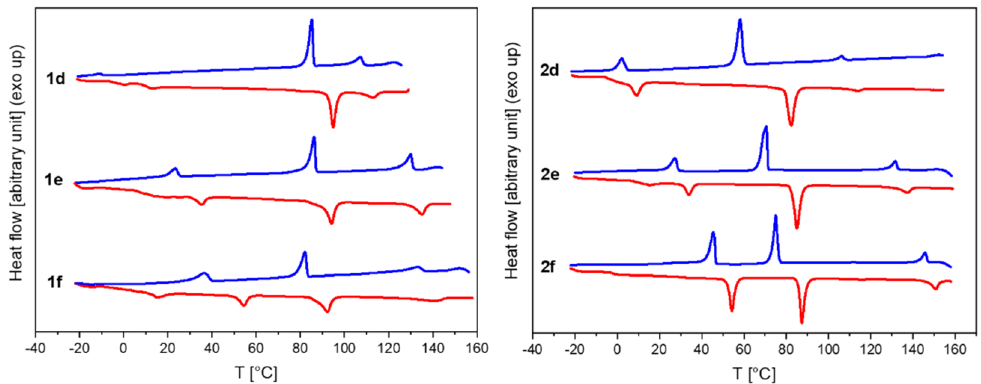
Figure 1. Differential scanning calorimetry (DSC) recorded for 1d-f and 2d-f showing the second cooling and heating curves with 10 °C min − 1 under nitrogen atmosphere. Exothermic peaks point upward.